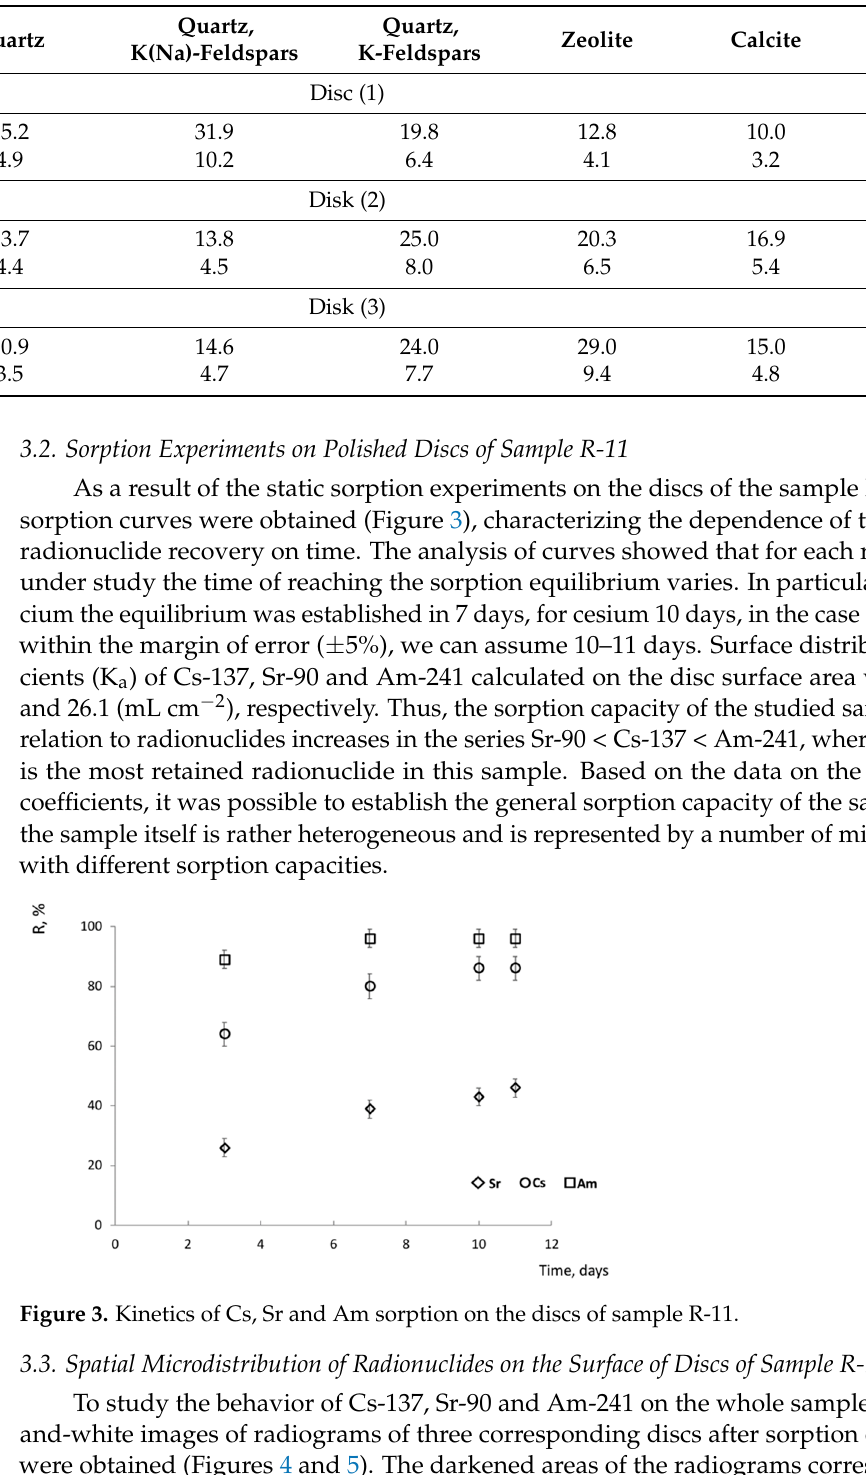
Figure 4. ( A ) optical image of sample R-11(disc (3)); ( B ) radiogram of americium sorption on sample R-11 (disc (3)); ( C ) elemental map of Ca distribution on the surface of R-11 sample (calcite identify- ing); ( D ) elemental map of Al distribution on the surface of R-11 sample (identifying of chlorite, epidote, feldspars, zeolite).